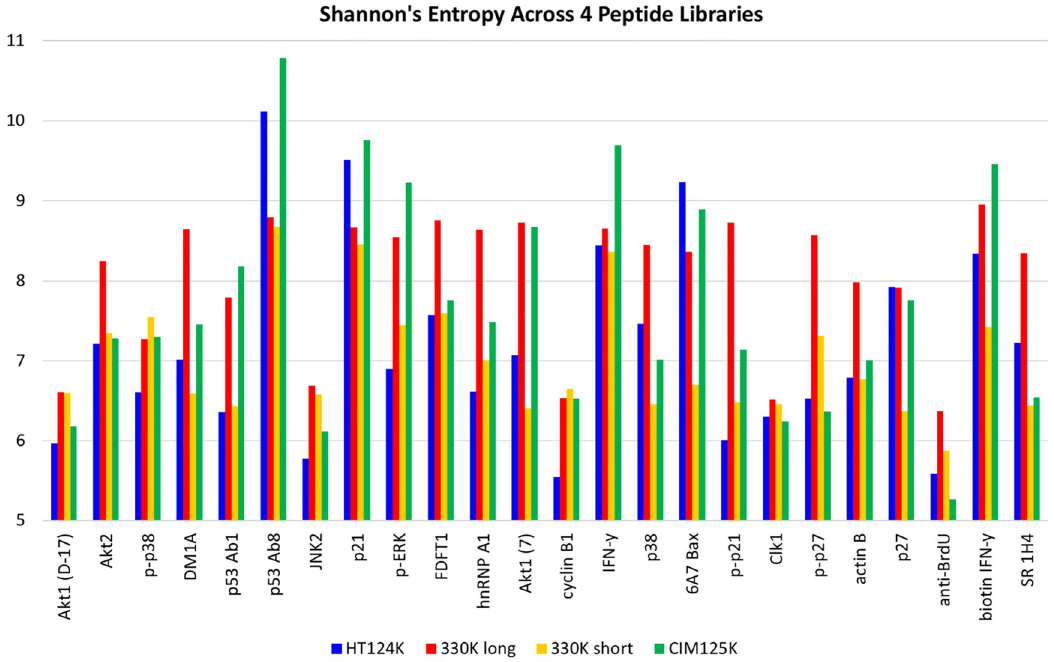
Fig 2. Entropy measures of each of the 24 different monoclonals tested. Shannon’s Entropy was calculated for each of the monoclonals and each of the 3 different peptide libraries. Since each peptide library is different, entropy calculations will differ as well, however a general trend shows that p53Ab8 has generally high measured entropy and anti-BrdU the